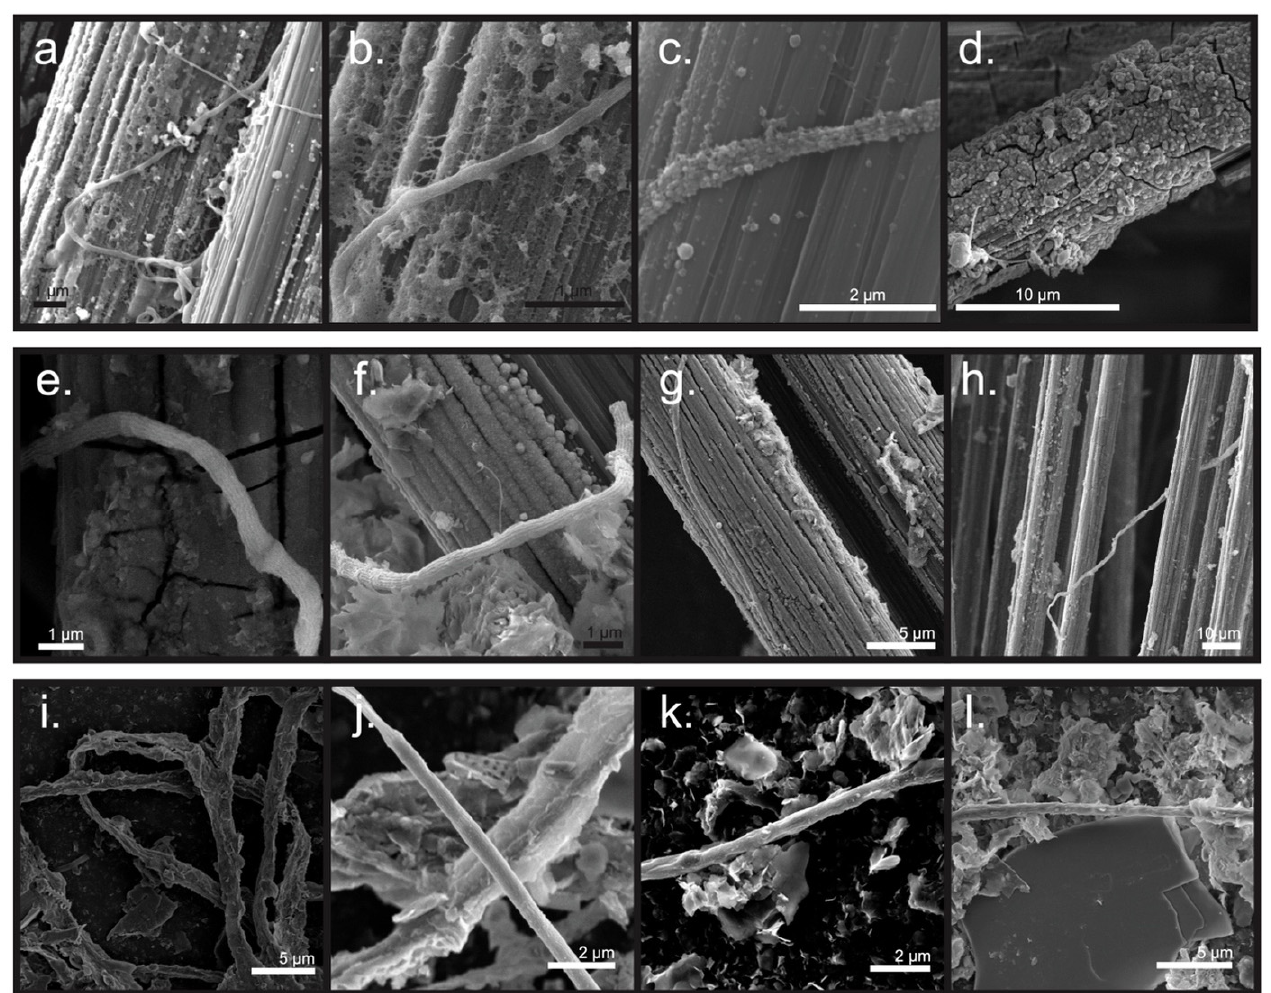
Figure 5. SEM images illustrating: ( a – d ) filamentous biomass on the surfaces of anode carbon fibers of reactor A, ( e – h ) fila- mentous biomass on and between ( h ) the surfaces of anode carbon fibers of reactor B, ( i , j ) filamentous biomass extracted from the uppermost sediment inside reactor A after 184 days of cultivation, and ( k , l ) filamentous biomass extracted from the uppermost sediment inside reactor B after 184 days of cultivation.